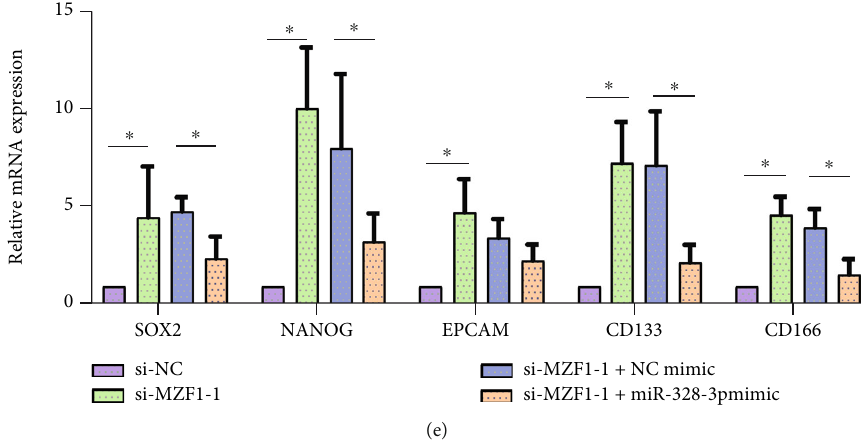
Figure 6: MZF1 inhibited the progression of STAD via promoting miR-328-3p expression. To further indicate whether MZF1 could a ff ect STAD development in a miR-328-3p-dependent manner, AGS cells were cotransfected with si-MZF1 and miR-328-3p mimics. (a) CCK-8 assay was used to evaluate the proliferation rate of AGS cells. (b) Western blot assay was performed to detect the expression levels of apoptosis-related proteins. (c, d) The migration and invasion of AGS cells were assessed with (c) wound healing and (d) Transwell assays. (e) qRT-PCR analysis of the expression levels of stem landmarks. Scale bar = 100 μ m. All experiments were performed in triplicate. ∗ P < 0 : 05 , ∗∗ P < 0 : 01 , and ∗∗∗ P < 0 : 001